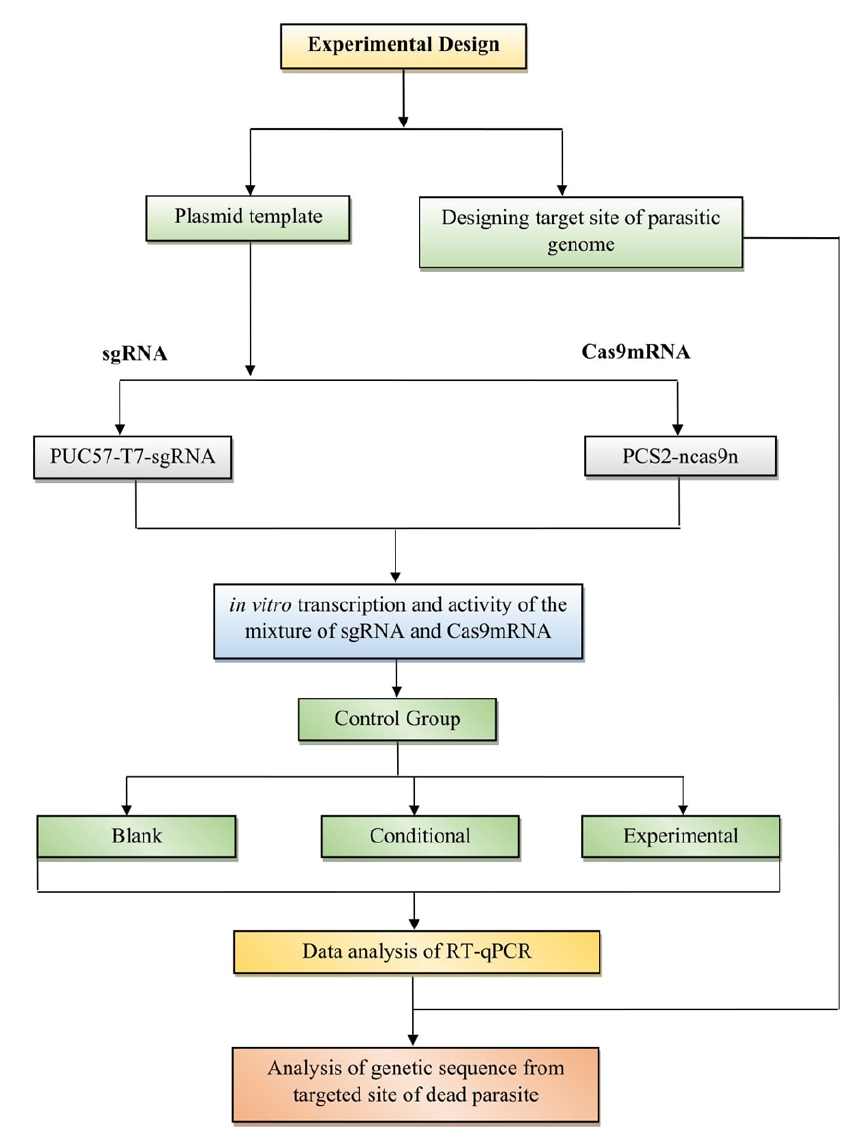
Figure 2. Experimental design of developing an RNA anti-parasite.